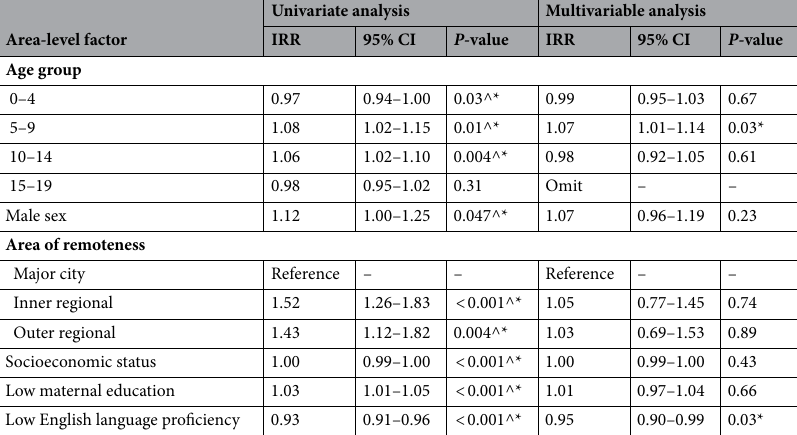
Table 1, surgical waiting time was significantly associated with likelihood of surgery, with every one day increase in the median wait time in a LGA there was a 1% reduction in the likelihood of surgery (IRR 0.99635 95% CI